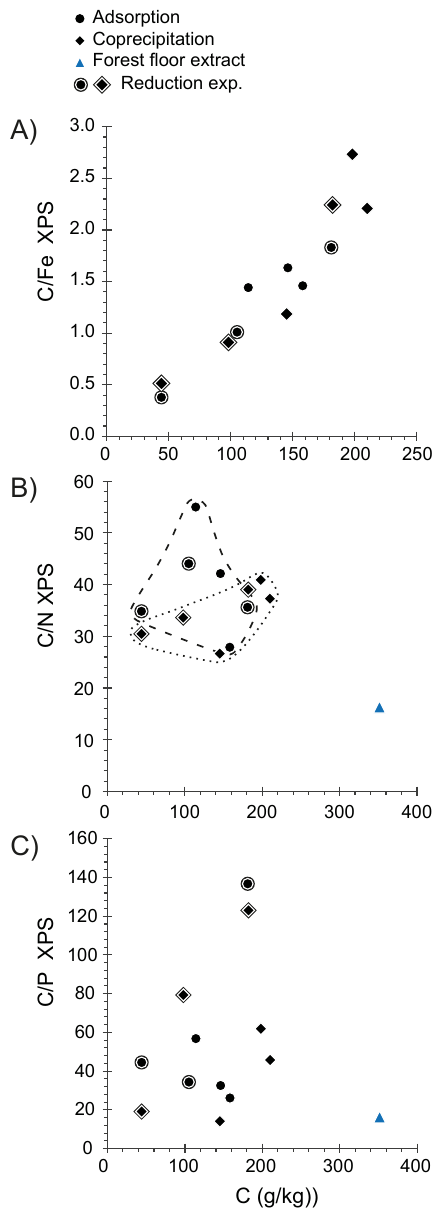
Figure 5. Comparison of chemical surface composition expressed in XPS signal ratios (C / Fe, C / N, and C / P) and bulk C content of Fh-OM associations. Dashed and dotted lines in (b) encircle XPS data for adsorption complexes and coprecipitates, respectively, to guide the